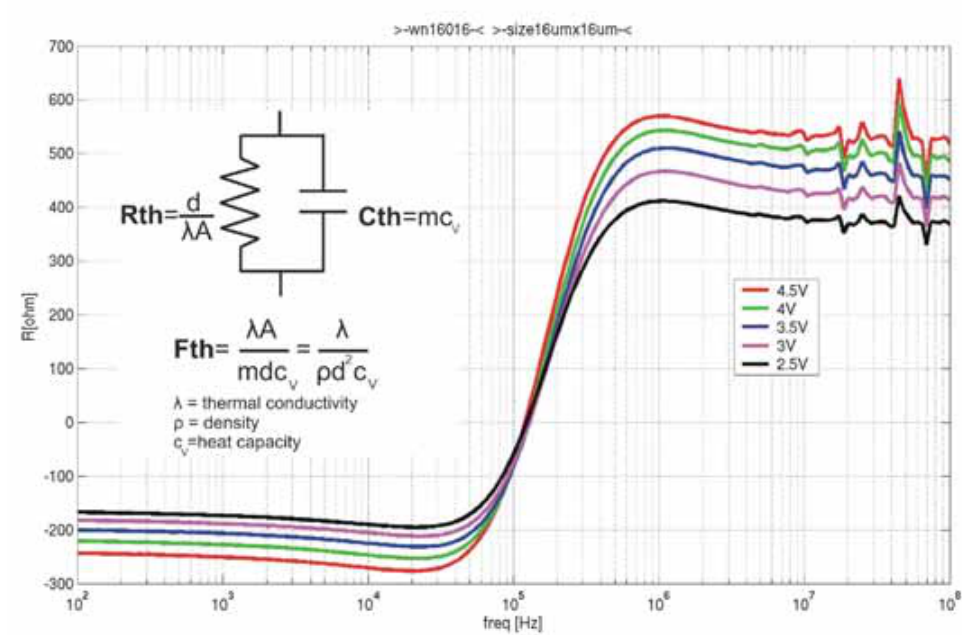
Figure 9. Impedance measurements of a Gunn diode without spacer layers at different supply voltages.